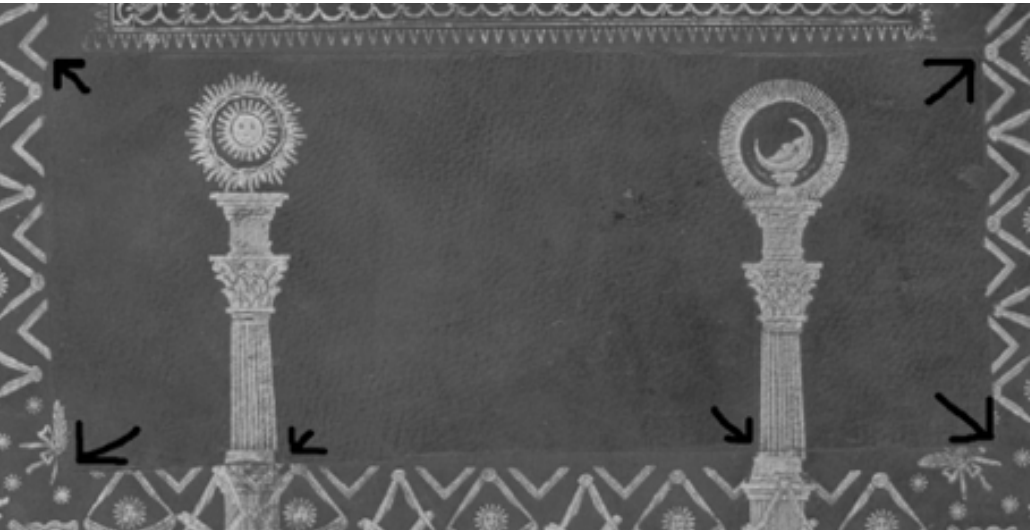
Fig. 31a. The Constitutions of the ... Masons (London, 1767-1776). Upper cover. Arrows indicate the edges of the patch and misalignment of tools. BL,